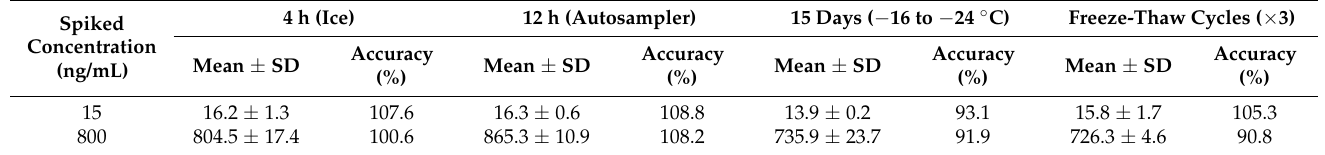
Table 3. Stability of Hu7691 (n =